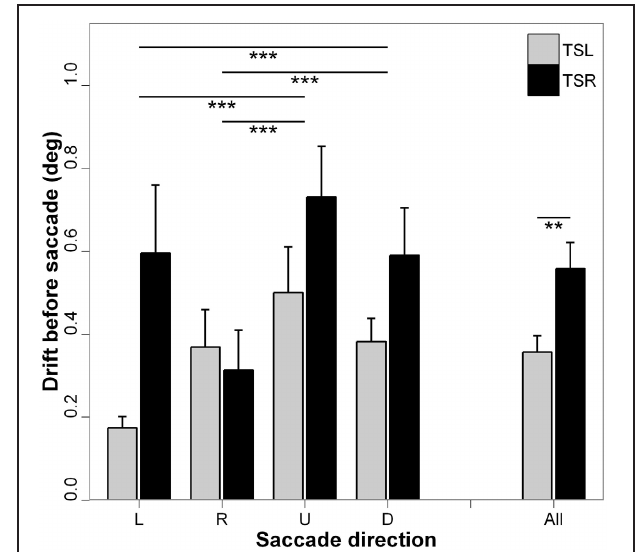
FIGURE 3 | Absolute mean values of fixation drift before saccade for each saccades direction (L, leftward; R, rightward; U, upward; D, downward) and tinnitus side (TSL, tinnitus side left; TSR, tinnitus side right). Error bars represent the standard error. The symbol ∗ indicates a statistically significant effect ( ∗ p < 0 . 05; ∗∗ p < 0 . 01; ∗∗∗ p < 0 .